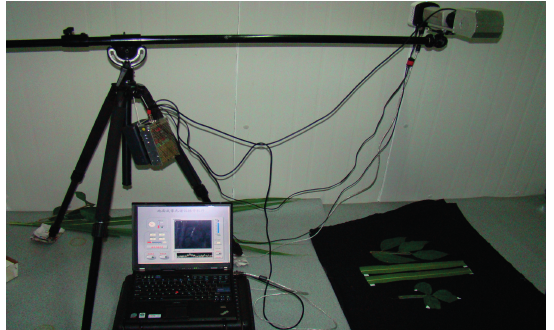
Figure 3. Actual photograph of FISS field